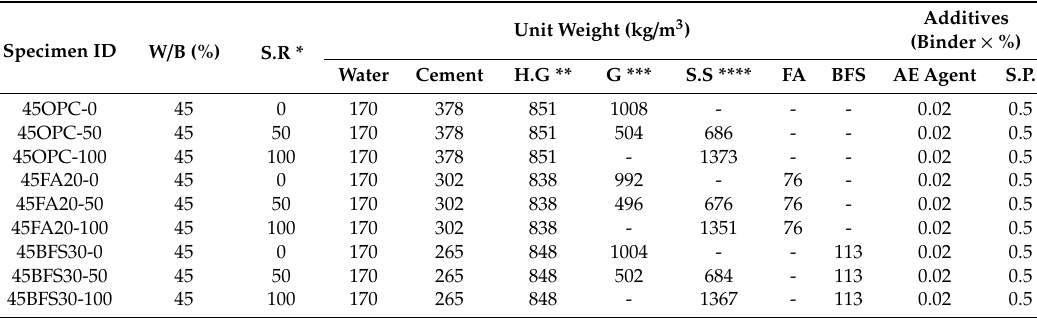
Table 7. Concrete mix